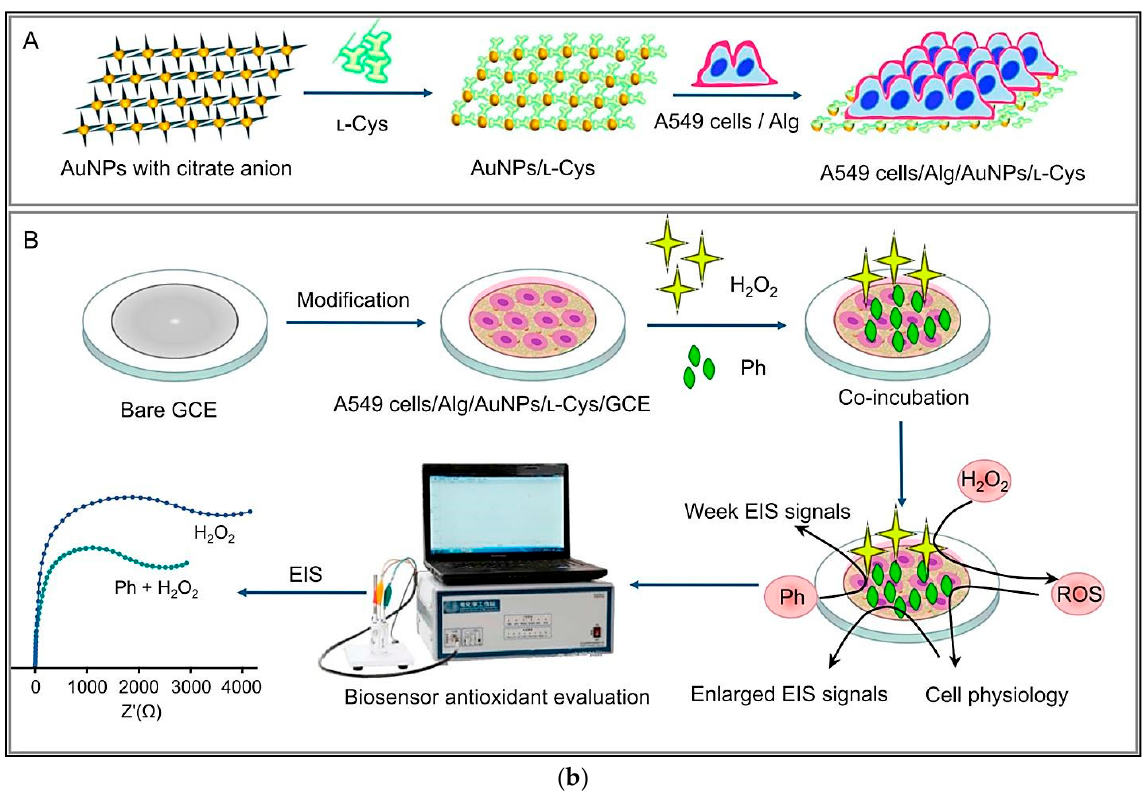
Figure 5. ( a ) RAW264.7 cell-based biosensor fabrication process and antioxidant analysis; ( b ) A549 cell-based biosensor fabrication steps ( A ) and process of antioxidant measurement ( B ). Reproduced with permission from [100,102], respec- tively.